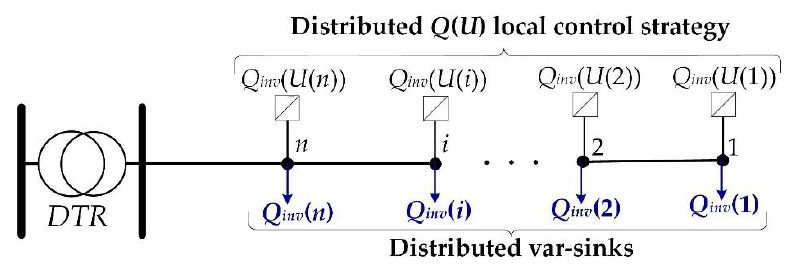
Figure 1. Overview of the distributed Q ( U ) local control strategy or rather distributed var-sinks. Concentrated Volt/var local control strategy is when one reactive power device (e.g., coil or inductance, L ) upgraded with a Volt/var local control (e.g., L ( U )) is applied mostly at the end of the feeder to mitigate the violation of the upper voltage limit. A concentrated var-sink is the